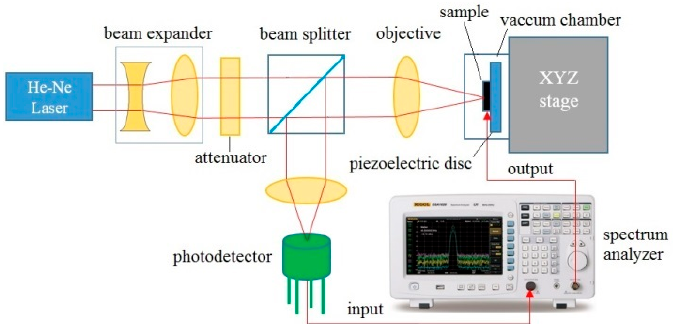
Figure 2. Schematic diagram of interferometric system employed for the measurements of resonant frequency of SiCN nanostrings. From [36].